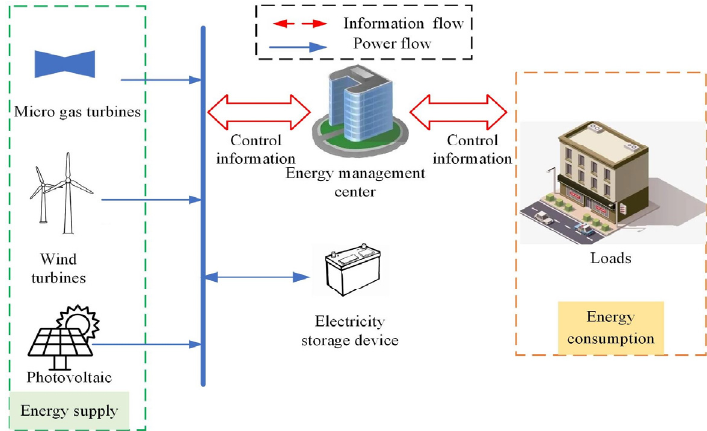
Figure 1. Schematic diagram of an individual MG structure.